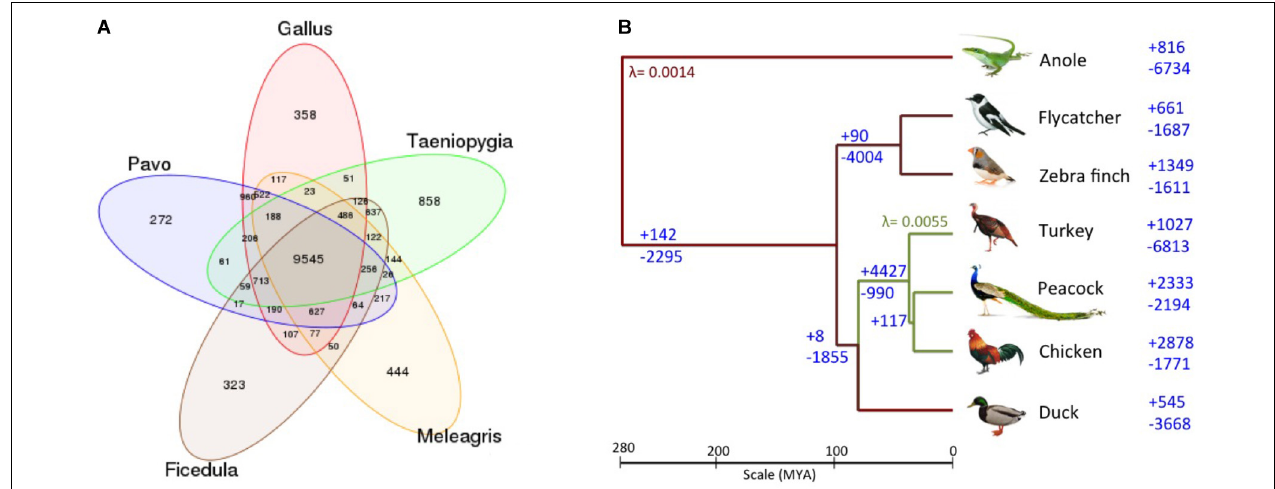
FIGURE 3 | (A) Venn diagram of gene families identified using TreeFam. A total of 9,545 gene families were common among the five bird genomes. 522 gene families were unique to the genus ( Pavo , Gallus, and Meleagris ) of Galliformes order, whereas, 637 gene families were unique to the genus ( Ficedula and Taeniopygia ) of Passeriformes order. (B) Gene gain/loss in the six avian species and anole. The number of gene gain (+) and loss (-) are mentioned on the right of the taxa (branches), for the six avian species and an outlier green anole. The gene gain and loss were calculated using CAFE two-lambda model with λ = 0.0055 for Galliformes and λ = 0.0014 for the rest of the